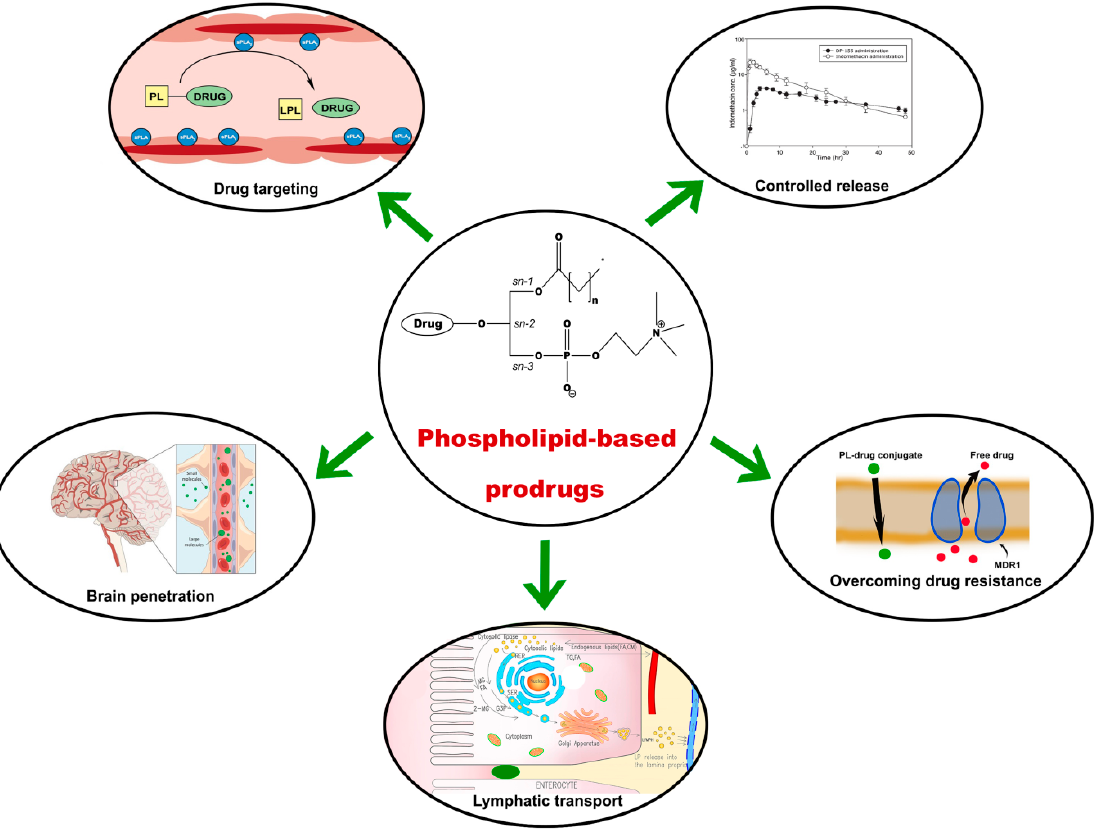
Figure 8. Illustration of the major challenges and potential solutions afforded by the PL-based prodrug approach. prodrug